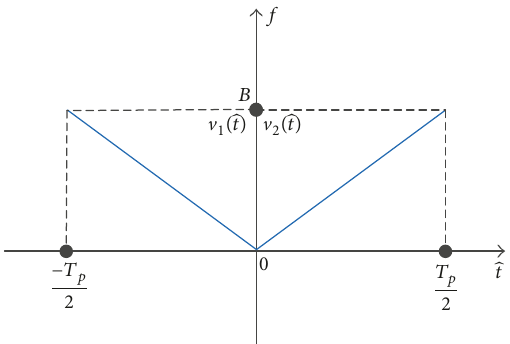
Figure 1: Sketch map of V-FM waveforms in time-frequency